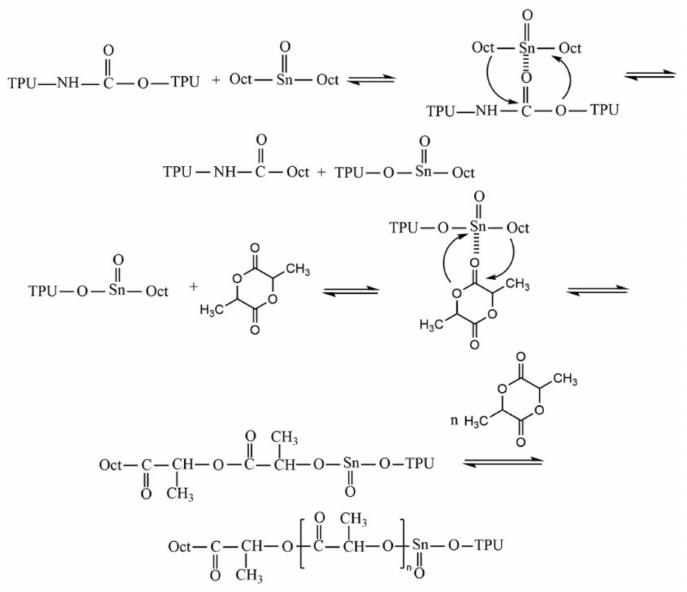
Figure 4. Probable reaction mechanism of PLA/TPU